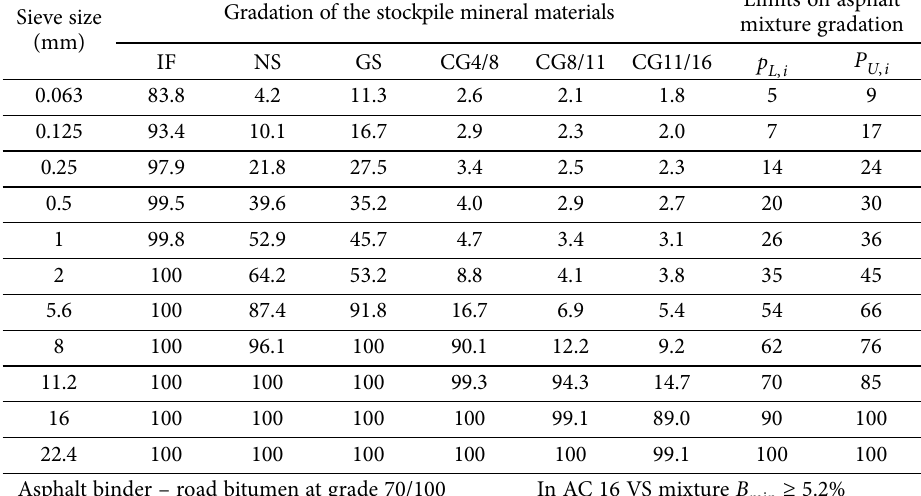
Table 1. The gradation of stockpile materials and gradation limits in the AC 16 VS asphalt mixture (percent passing) Sieve size (mm)